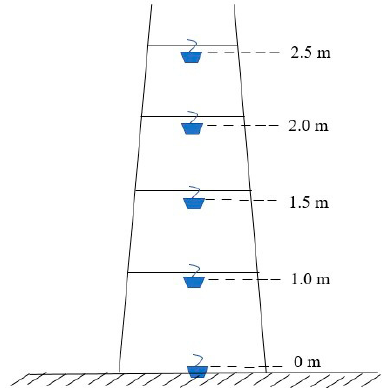
Figure 4. Trapezoidal frame used to hang the traps at different heights.